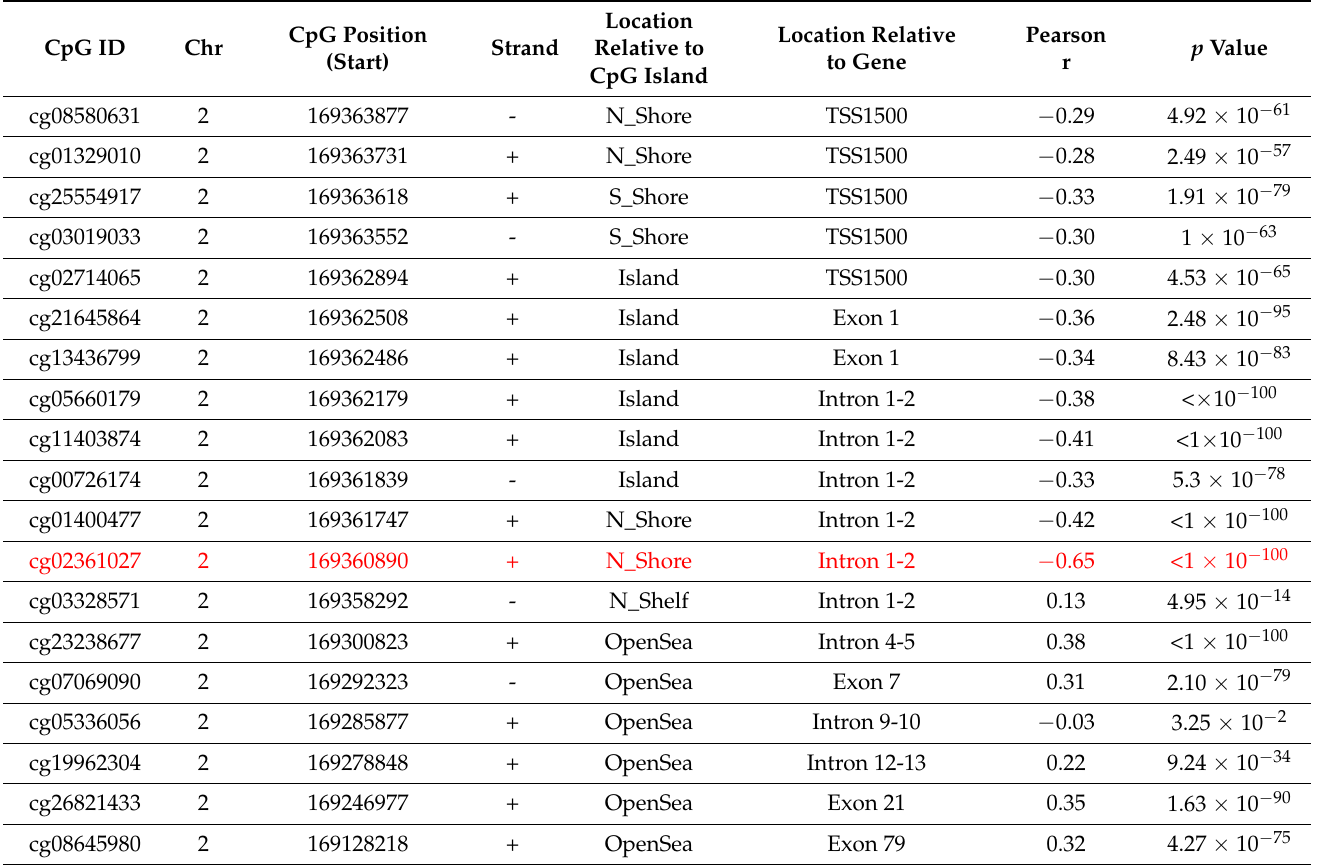
Table 1. CpG methylation in the LRP2 gene locus. CpG IDs and related information from the Illumina450K manifest file. CpG IDs 1 to 2 (from top) are related to a CpG island located on chromosome 2 position 169364262-169364604. CpG IDs 6 to 13 (from top) are related to a CpG island located on chromosome 2 position 169361804-169363035. Pearson’s R and corresponding p values between LRP2 expression and β values for each CpG site in KIRC, KIRP, MESO, THCA, BRCA, LUAD, and SKCM are shown. cg02361027 at position 169360890, which shows a strong inverse correlation to LRP2 expression, is highlighted in